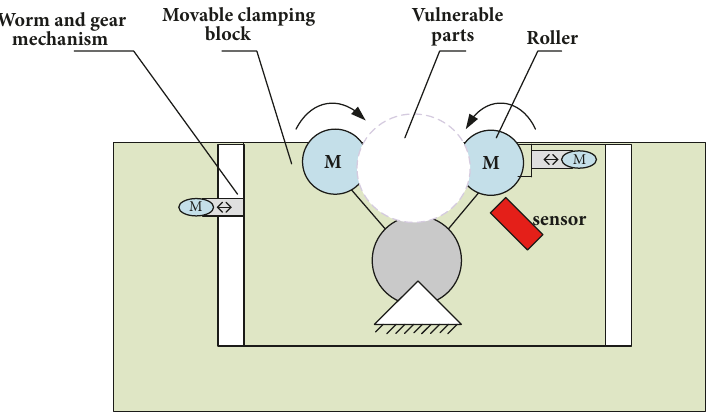
Figure 9: Initial plan